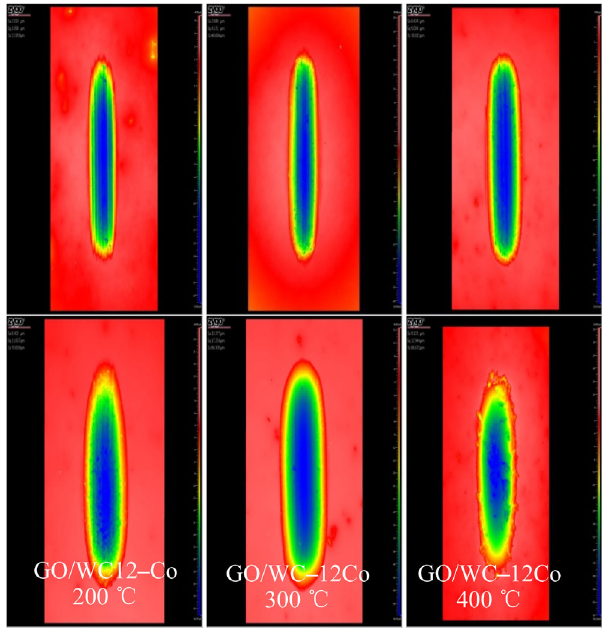
Fig. 10 Morphologies of the wear tracks in the coatings after undergoing high-temperature